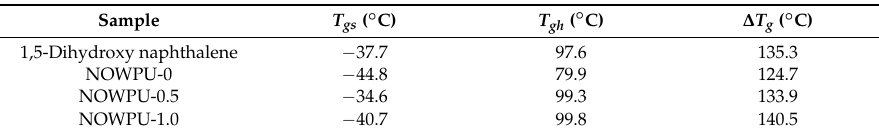
Table 3. Maximum initial decomposition temperature ( T 0 ), maximum temperature ( T max ), and